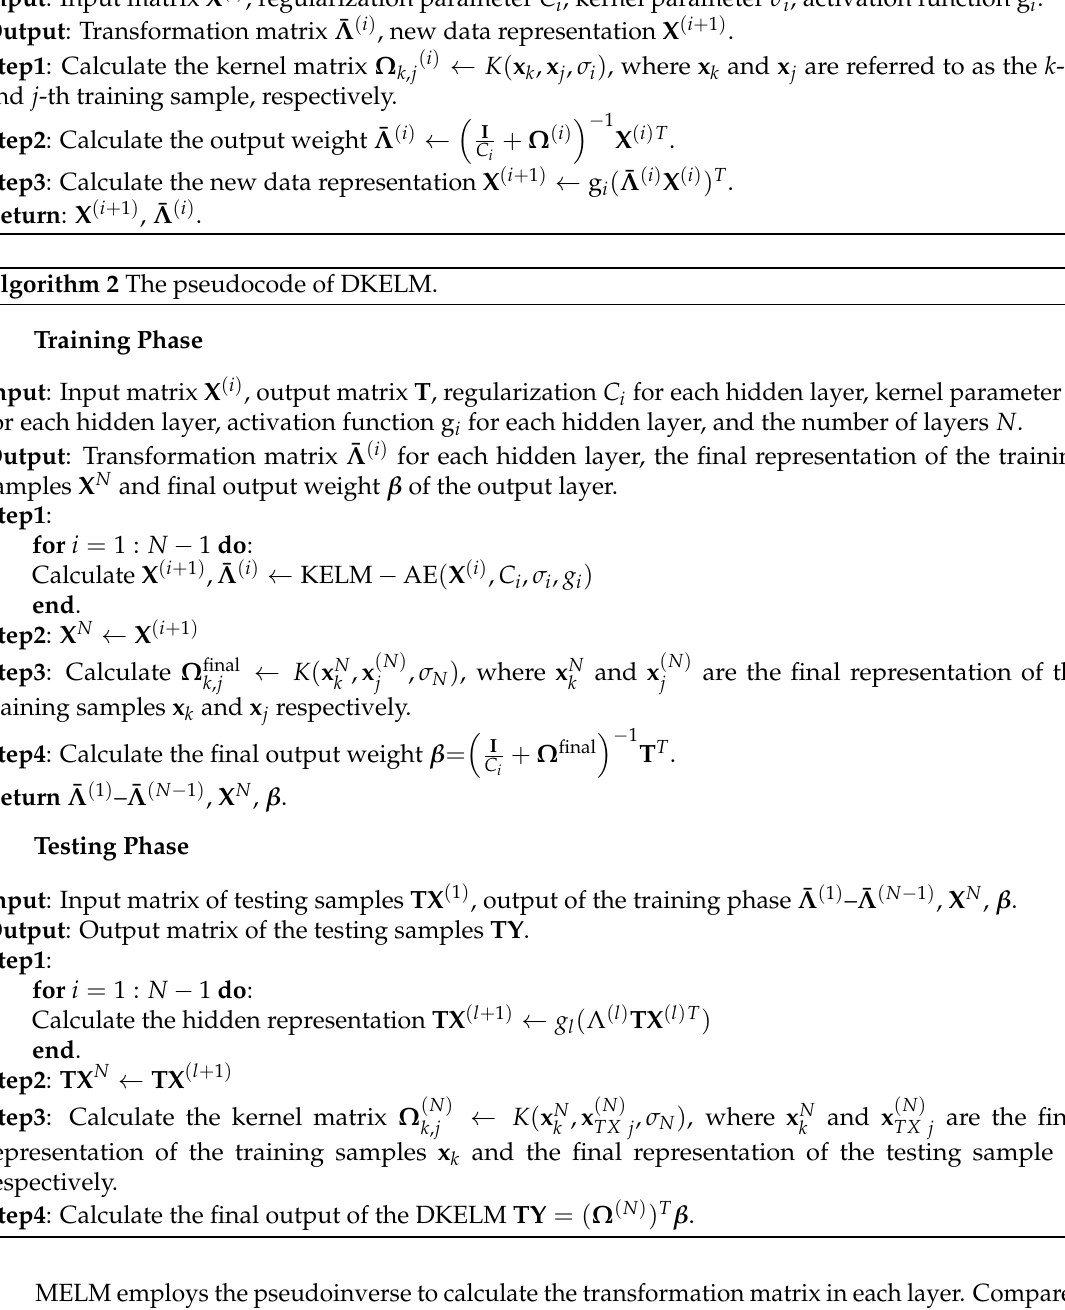
Algorithm 1 The pseudocode of KELM-AE.